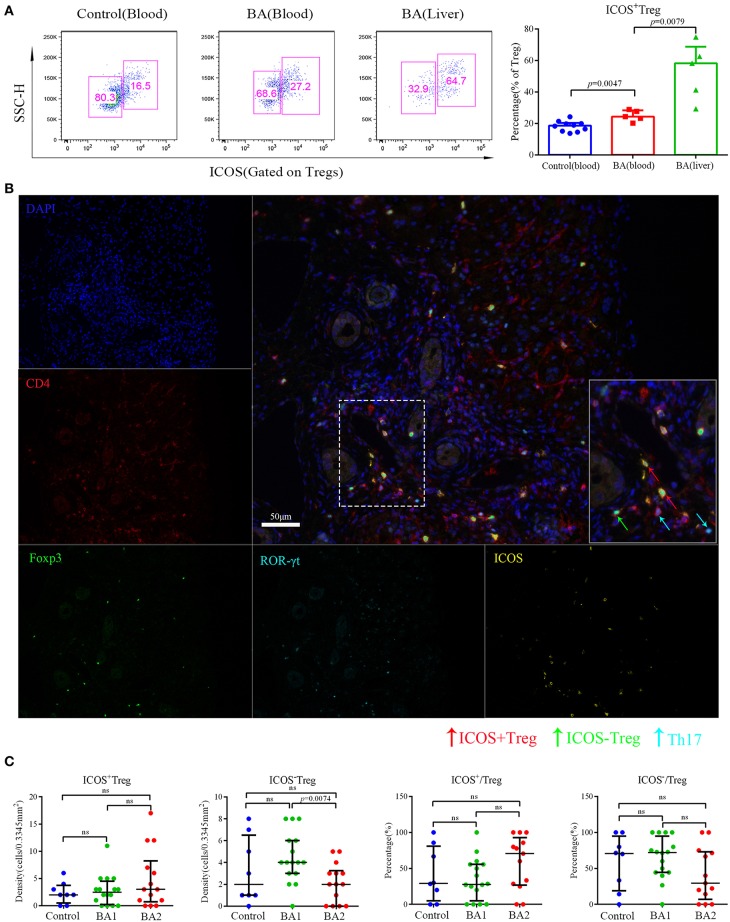
Flow cytometry and mIHC analyses of Treg subsets. (A) Representative flow cytometry image (left) and statistical analysis (right) of ICOS expression on Tregs. Control patients included four patients with brachial plexus injury and six patients with accessory ear. (B) The five small images were single stain of DAPI (blue), CD4 (red), ROR-γt (cyan), Foxp3 (green), and ICOS (yellow). Merged image on the right upper side showed Th17 (CD4+ ROR-γt +) ICOS+Treg (CD4+Foxp3+ICOS+) and ICOS−Treg (CD4+Foxp3+ICOS−). The lower right image in the merged image was the magnification of dotted line area. (C) Analyses of the densities and percentages of Treg subsets among control (choledochal cyst), BA1 (good prognosis), and BA2 (poor prognosis) groups. Mann-Whitney test was used.